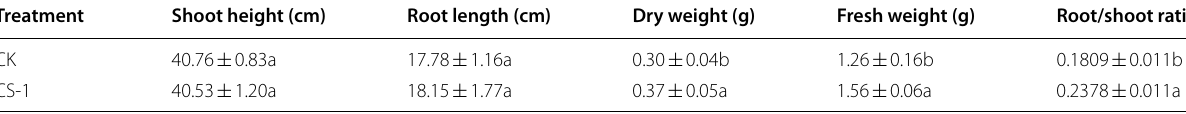
Values are mean SD (n 30). Means sharing a common letter within the same column are not significantly different at P < 0.05 . “CS-1” denotes wheat seedlings ± = treated with a suspension of strain CS-1 spores. “CK” denotes wheat seedlings treated with an equal volume of sterile water Table 4 Diversity and richness indices of bacterial and fungal community from CS-1 treatment and control